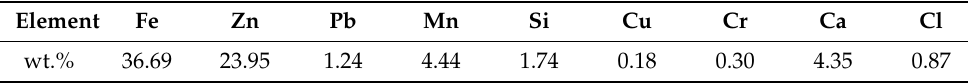
Table 1. Chemical composition of steelmaking dust.